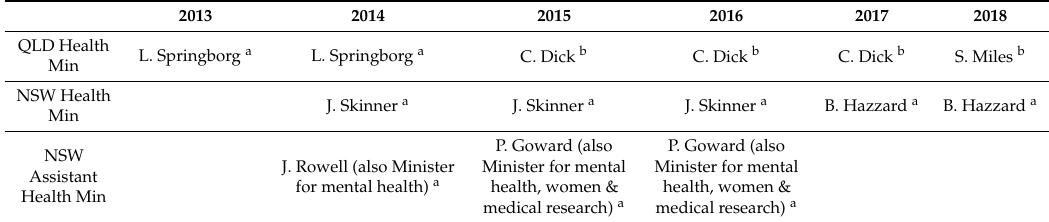
Table 1. Changes in health ministers in New South Wales and Queensland